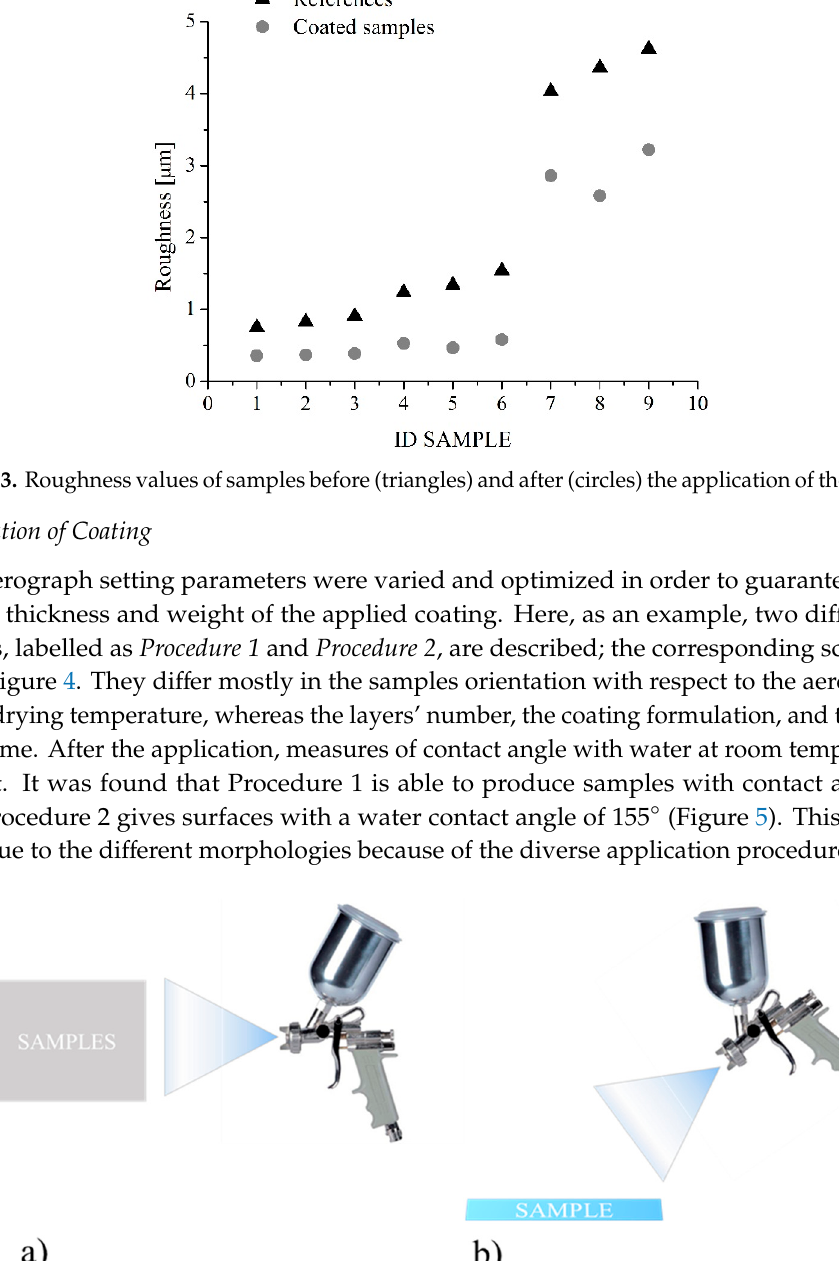
Figure 5. Pictures related to the water contact angle of coated samples prepared according to ( a ) Procedure 1 and ( b ) Procedure 2. Hence, Procedure 2 was adopted to apply three layers of the developed coating on sample 1–9 with dimensions of 5 × 5 cm 2 . The Samples were weighed before and after the application of the coating, in order to